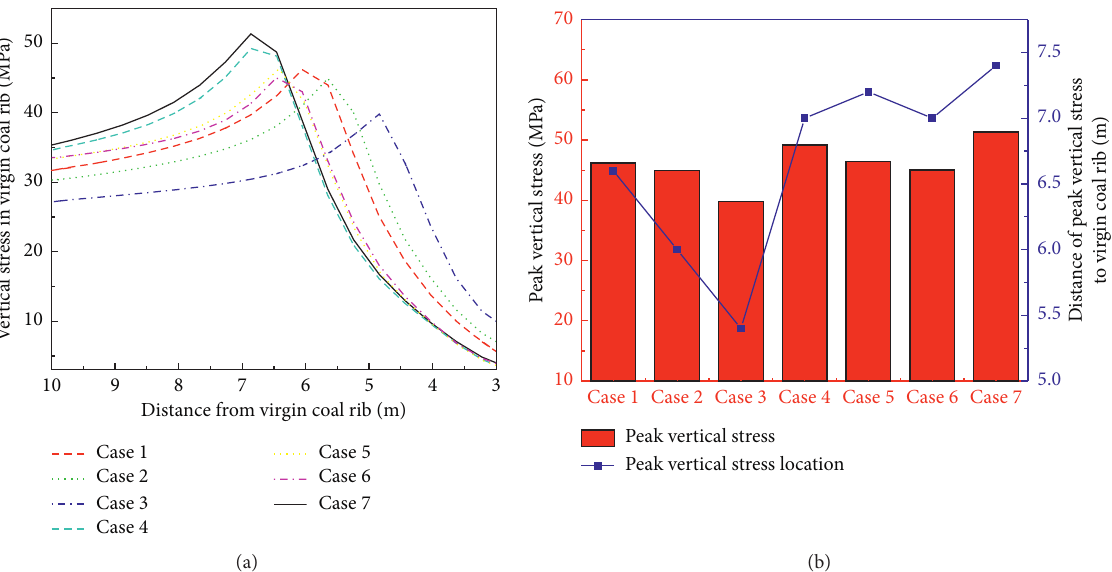
Figure 13: Vertical stress distribution in the coal ribs of retained gob-side entry. (a) Vertical stress in coal ribs under different fracturing heights and angles. (b) The peak values and locations of the vertical stress in coal